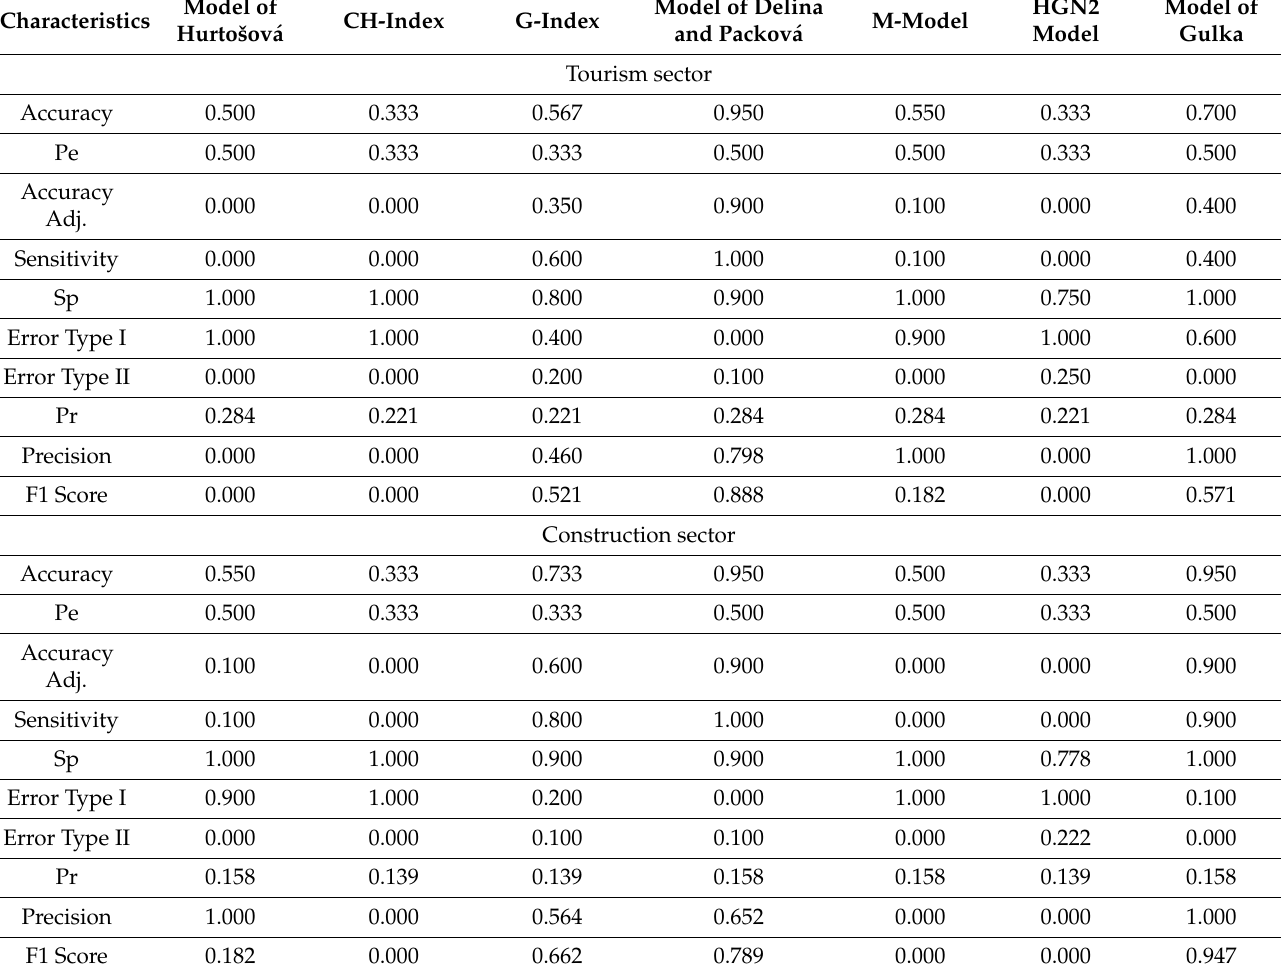
Table A7. Sensitivity and Precision results of alternative models,